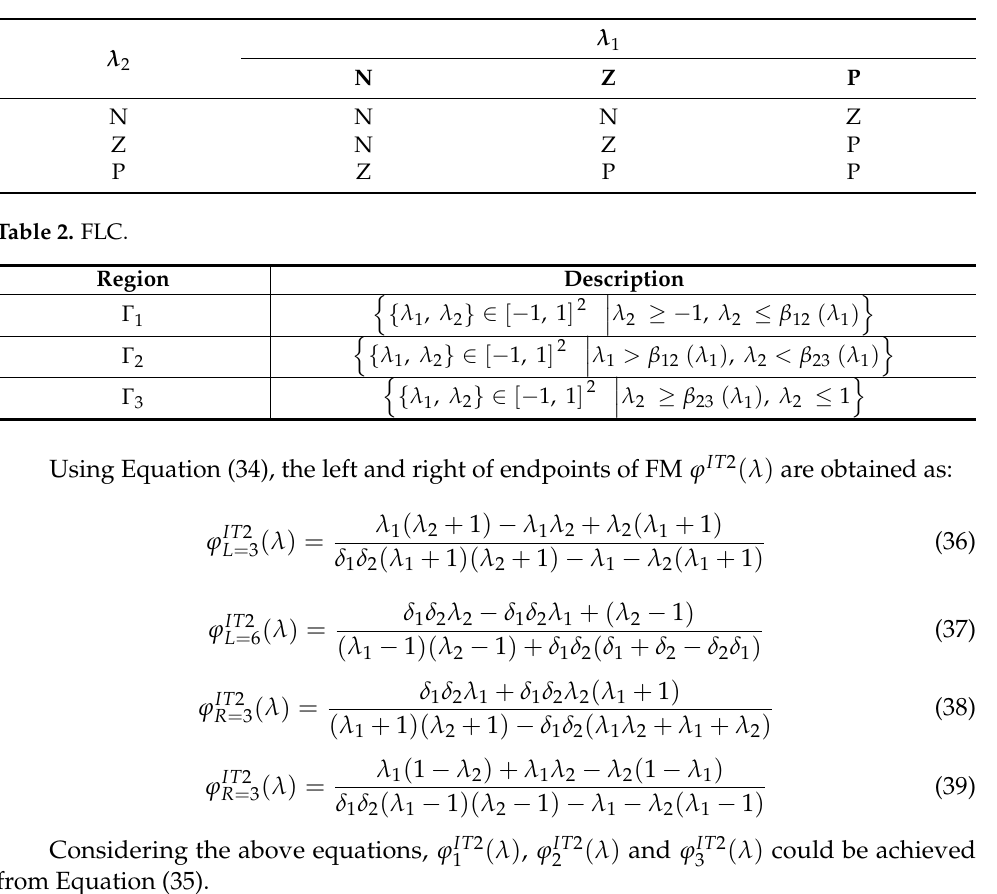
Table 1. Rule base of the DIT2-FLC.